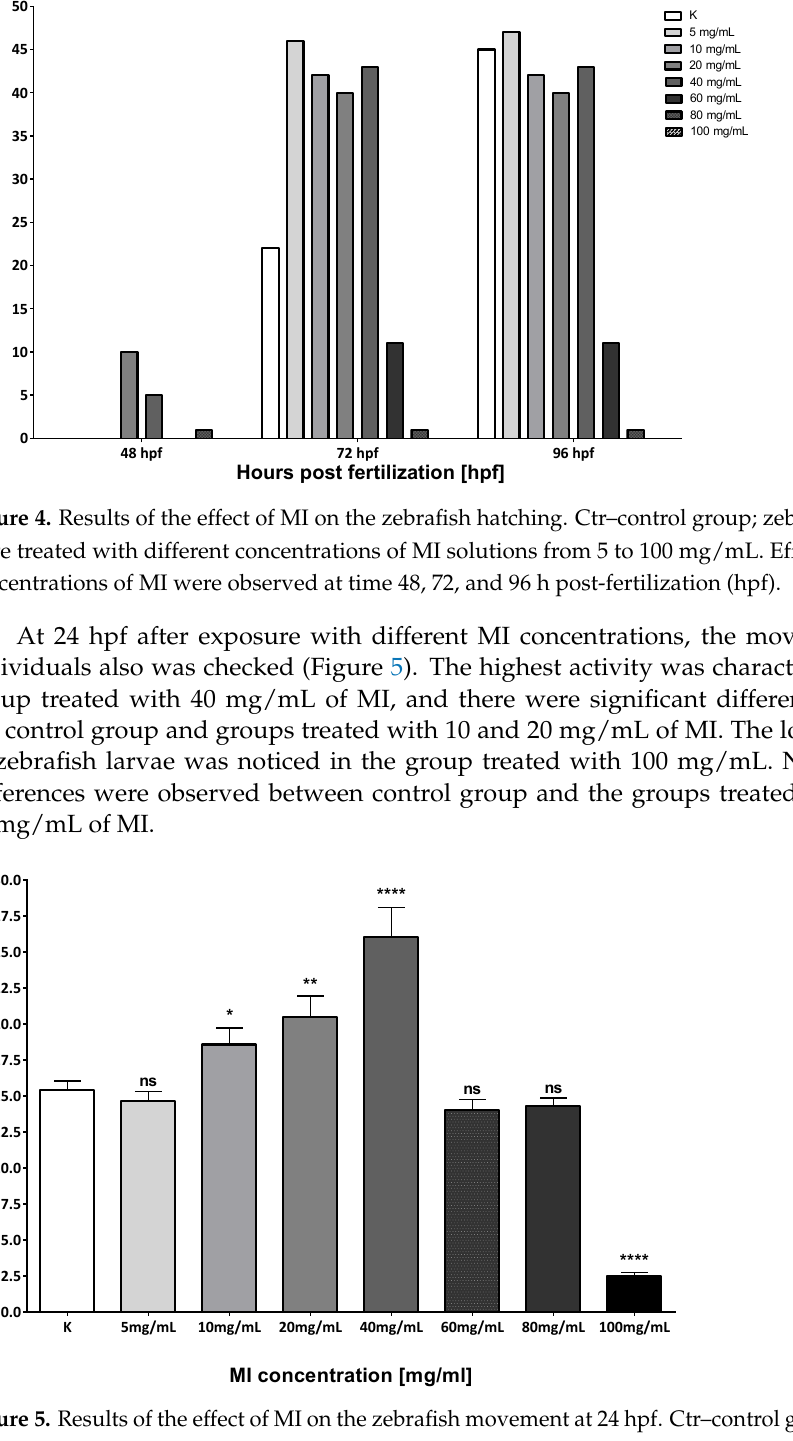
Figure 5. Results of the effect of MI on the zebrafish movement at 24 hpf. Ctr–control group; zebrafish larvae were treated with different concentrations of MI solutions from 5 to 100 mg/mL. Results were analysed by the t -test in GraphPad Prism 6. All groups were compared with control group-C. * p = 0.0184; ** p = 0.0017; **** p < 0.0001; ns =